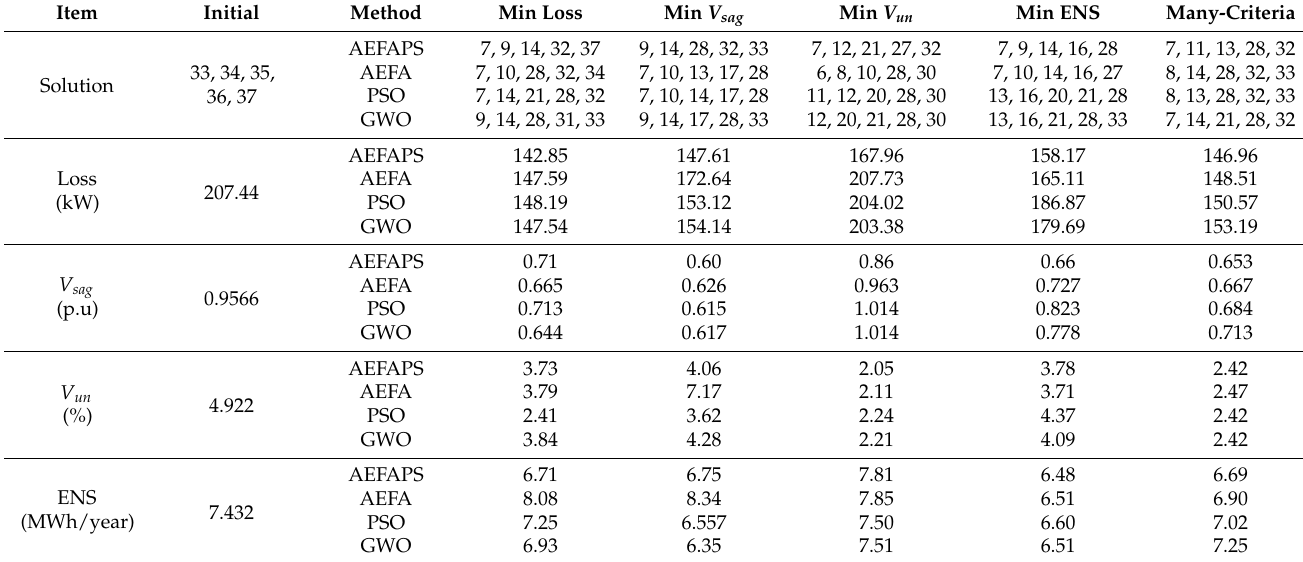
Table 3. Results of single-criterion and many-criteria reconfiguration of an unbalanced 33-bus network (rated load,